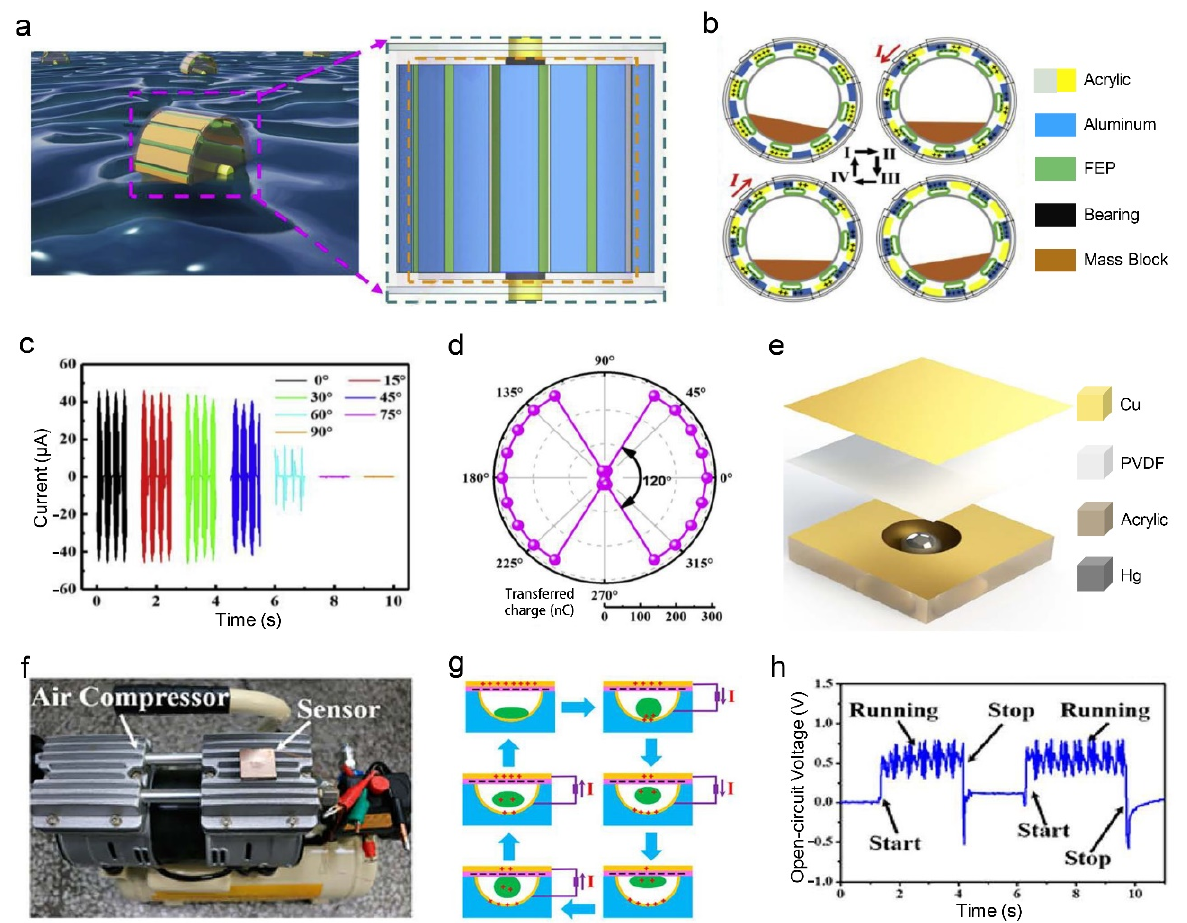
Figure 9. A curved surface contact vibration sensor: Part Two. ( a ) Schematic structure of the CP- TENG. ( b ) Working principle of the CP-TENG. ( c ) The short-circuit current of the CP-TENG at different angles. ( d ) Transferred charge of the CP-TENG at different excitation direction. Reproduced with permission [150]. Copyright 2020, Elsevier. ( e ) Structure design of the self-powered LM-TENG. ( f ) Demonstration of the LM-TENG fixed onto air compressor for vibration monitoring. ( g ) Working principle of the LM-TENG. ( h ) Open-circuit voltage of the LM-TENG during the start–stop process of the air compressor. Reproduced with permission [151]. Copyright 2017, American Chemical So- ciety.